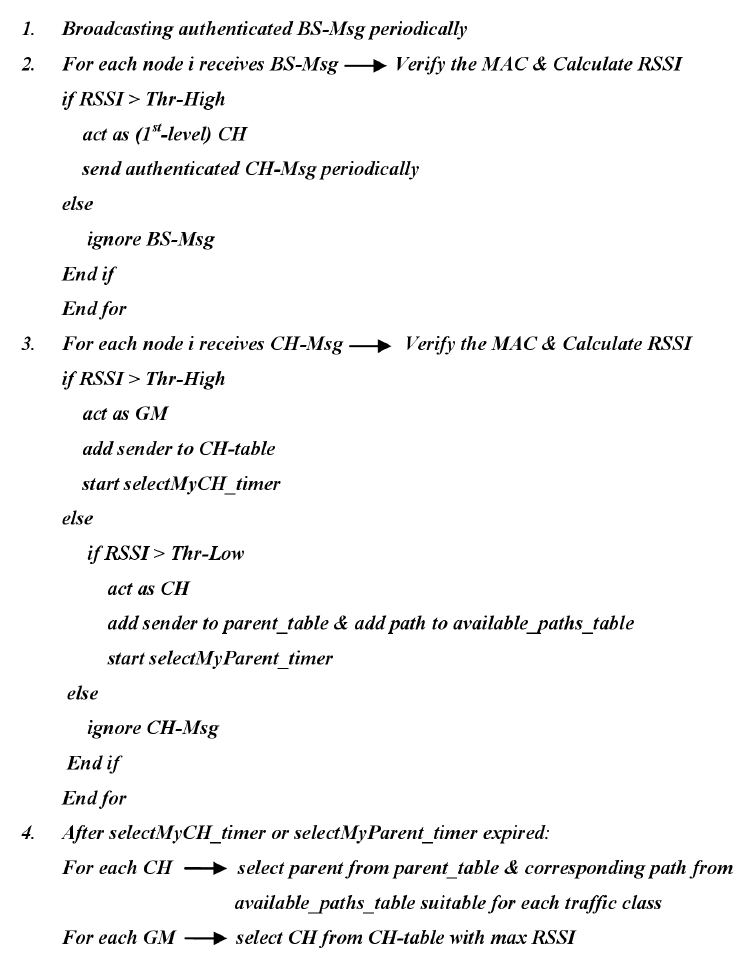
Figure 3. Pseudo-code of the Main Part of the Routing